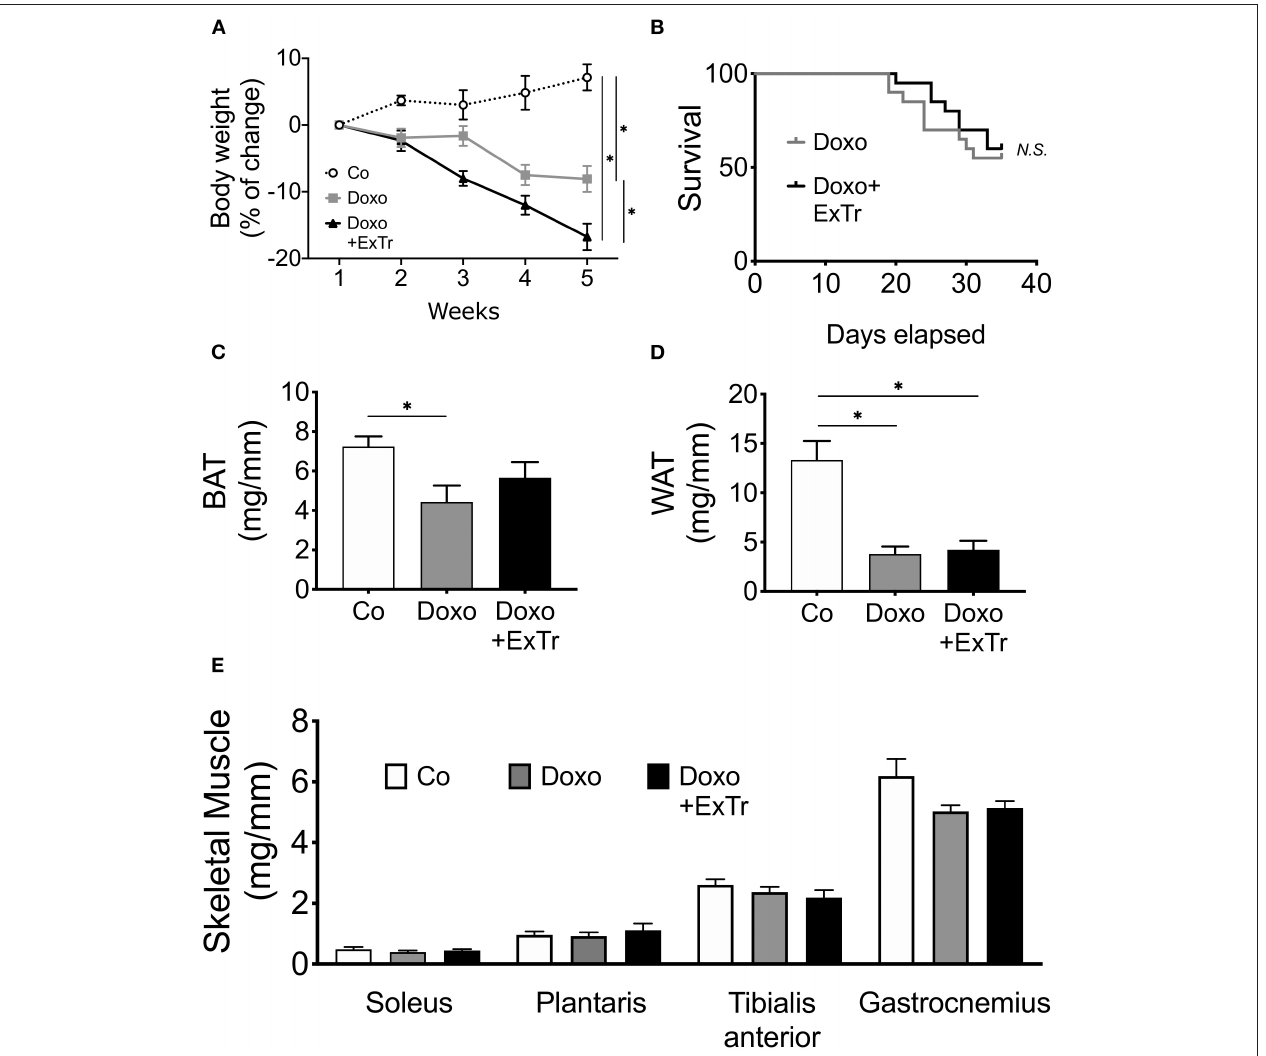
FIGURE 5 | ExTr exacerbates Doxo-induced body wasting. Doxo induces body wasting, which is exacerbated by ExTr (A) , although without negatively affecting survival (B) . Doxo affects fat depots mass, reducing both BAT (C) and WAT (D) adipose tissue. ExTr attenuates BAT mass wasting, but not WAT. No changes were found in skeletal muscle mass (E) . BAT, brown adipose tissue; WAT, white adipose tissue. Group abbreviations as in Figure 1 . n = 12–20 per group (A,B) or n = 8–10 (C–E) . * P ≤